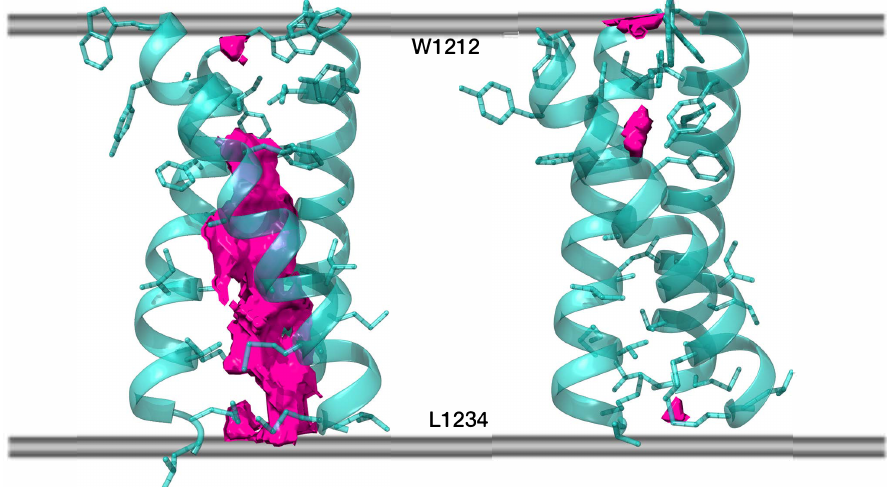
Figure 5. Free volume in the lumen of S _ TNFR1 ( left ) and in S _ OPT ( right ). Protein chains are partially transparent and are shown in cartoon representation; residues within each chain facing either of the remaining two chains are shown in stick representation. Free volume is rendered as solid pink blocks (averaging over 200 frames not applied), while the boundaries of the hydrophobic stratum of the membrane are schematically shown as grey